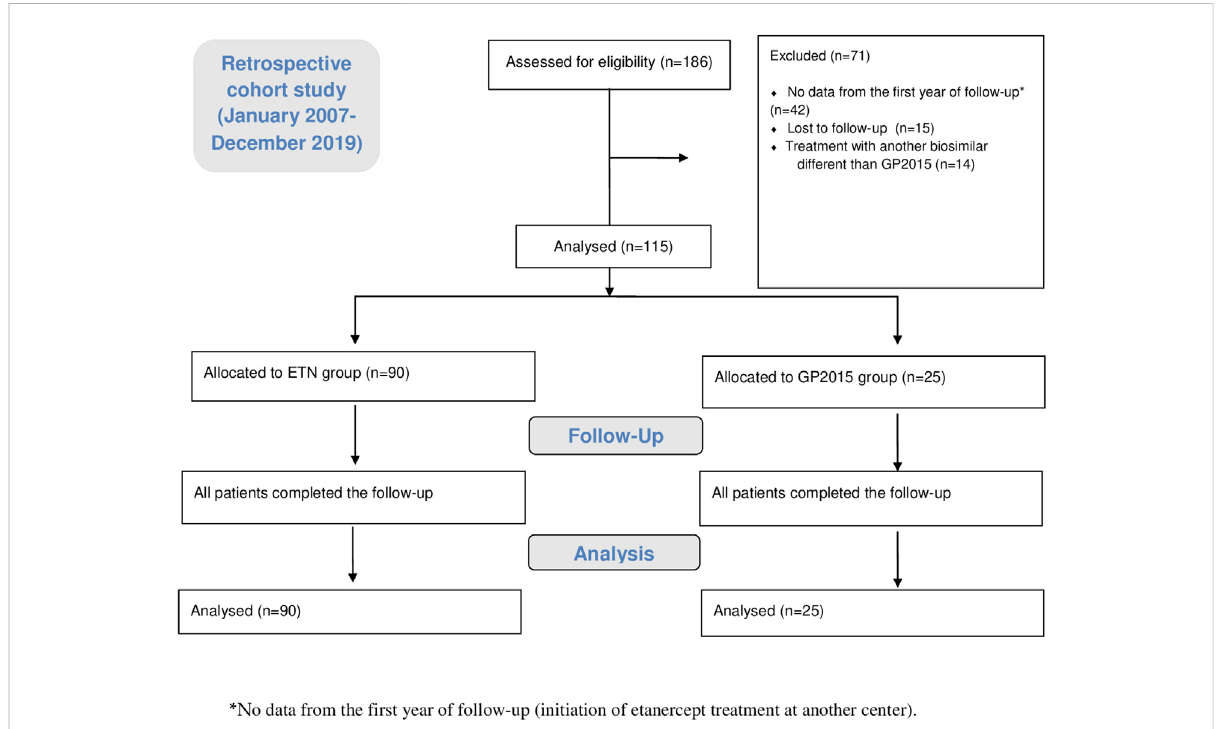
FIGURE 1 The study fl ow chart in line with the STROBE: 186 patients were initially assessed for eligibility, of which 71 were excluded. Finally, 115 patients were analyzed, 90 in the group ETN-treated patients and 25 in the group GP2015-treated patients. All patients completed the follow up. STROBE: (Strengthening the Reporting of Observational Studies in